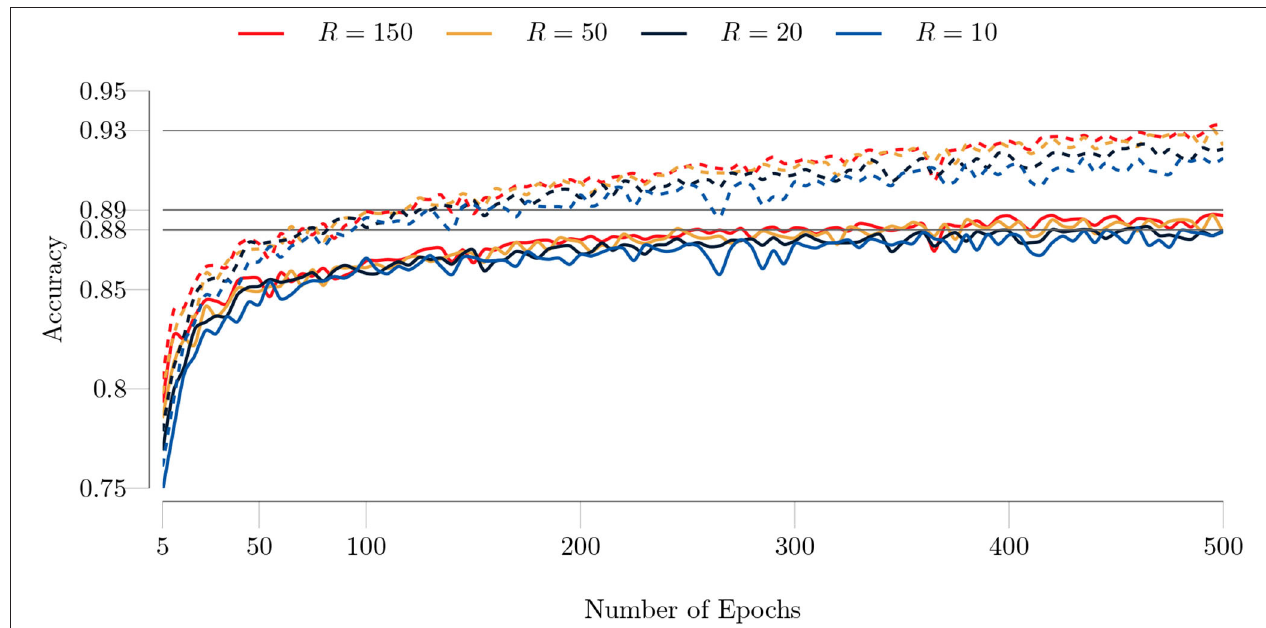
FIGURE 10 | Test (solid lines) and training (dashed lines) accuracies of the type I model for the Fashion MNIST dataset with respect to the number of epochs. The full training set (60,000 images) and test set (10,000 images) are used. The batch size is set to 100 and the maximum number of GN iterations is set to 1. Similar to the MNIST dataset, TeMPO achieves good accuracy even for low rank values and both the test and training accuracy mildly increase as the rank